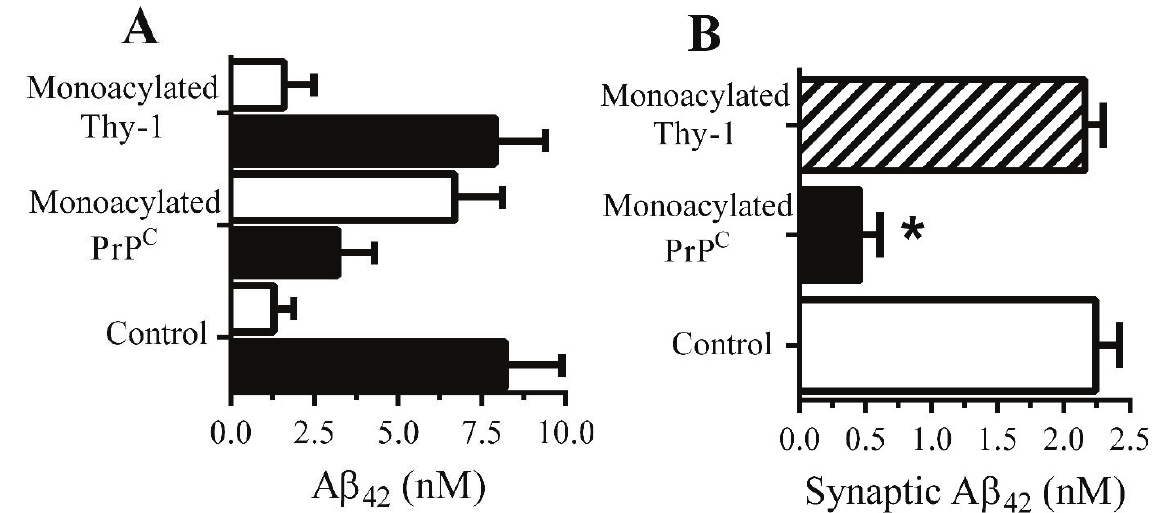
Figure 5. Monoacylated PrP C reduced the accumulation of Aβ 42 at synapses: ( A ) The concentrations of Aβ 42 in DRMs (■) or DSMs (□) of neurons pre -treated with control medium, 10 nM monoacylated PrP C or 10 nM monoacylated Thy-1 as shown and incubated with 10 nM Aβ 42 . Values are means ± SD from triplicate experiments performed three times ( n = 9). ( B ) The concen trations of Aβ 42 in synaptosomes derived from neurons pre-treated with control medium (□), 10 nM monoacylated PrP C (■) or 10 nM monoacylated Thy -1 (striped bar) and incubated with 10 nM Aβ 42 for 2 h. Values are means ± SD from triplicate experiment performed four times, n =